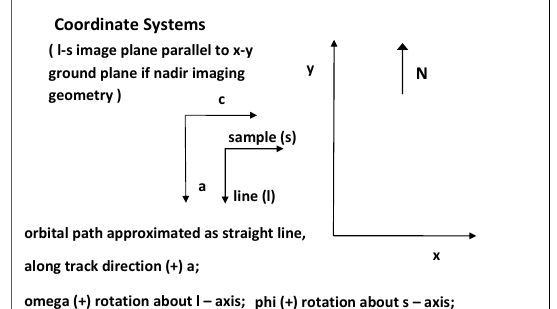
Figure 3. Simulation coordinate systems Specific to the simulation: the number of sensor adjustable parameters per image n =5 corresponding to along-track, cross- track, radial position components, and Euler angle omega and phi attitude components; imaging geometry is specifiable and expressed as nadir ground sample distance (nadir_gsd ), convergence angle ( conv ), roll angle ( roll ), and asymmetry